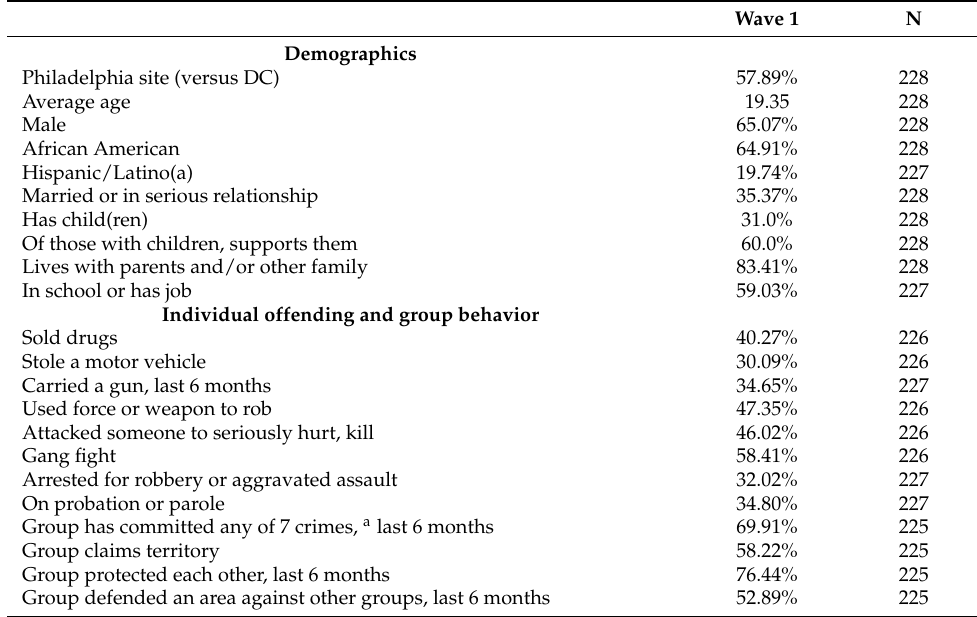
Table 2. Demographic Characteristics of Sample at Baseline, n =